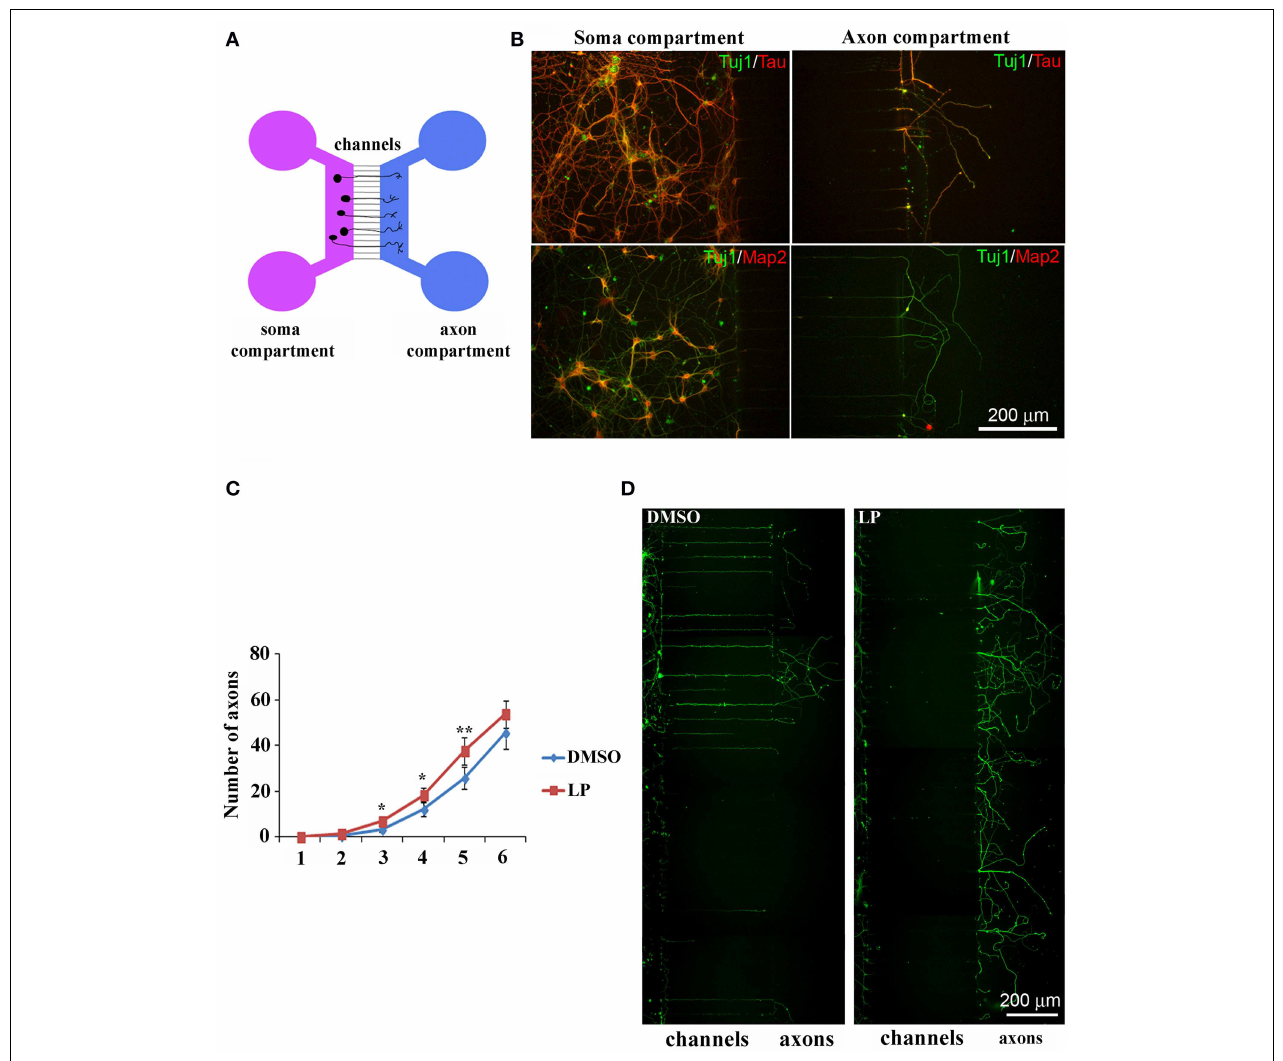
other compartment. (C) The number of axons crossing the micro-channels is significantly higher in LP-211 treated cultures (LP, red line), respect to control (DMSO, blue line), after 3, 4, and 5DIV. Asterisk (*): values significantly different from DMSO by One Way ANOVA followed by Dunnett post-hoc test ( p < 0 . 05 ). (D) Representative hippocampal cultures grown in the presence of DMSO or LP and immunolabeled with the Tuj1 antibody